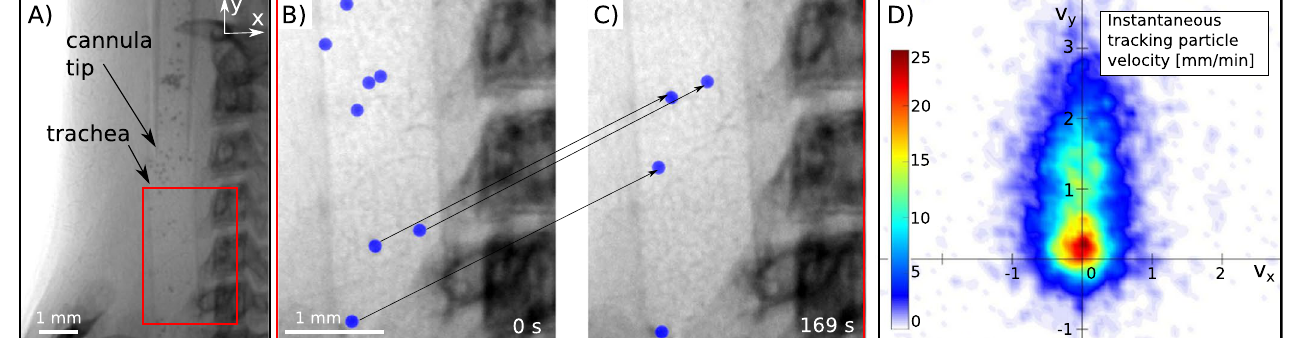
Figure 4. (A) Mucociliary clearance of inhaled beads in the trachea. Panels (B,C) show a magnified image of the trachea at different time-points with tracked beads marked in blue by the analysis software. Panel (D) shows the probability heat-map of the particle velocity due to the motion of the mucus layer. Positive v y direction: Transport towards the larynx. The colourbar indicates the number of tracked steps in the given velocity